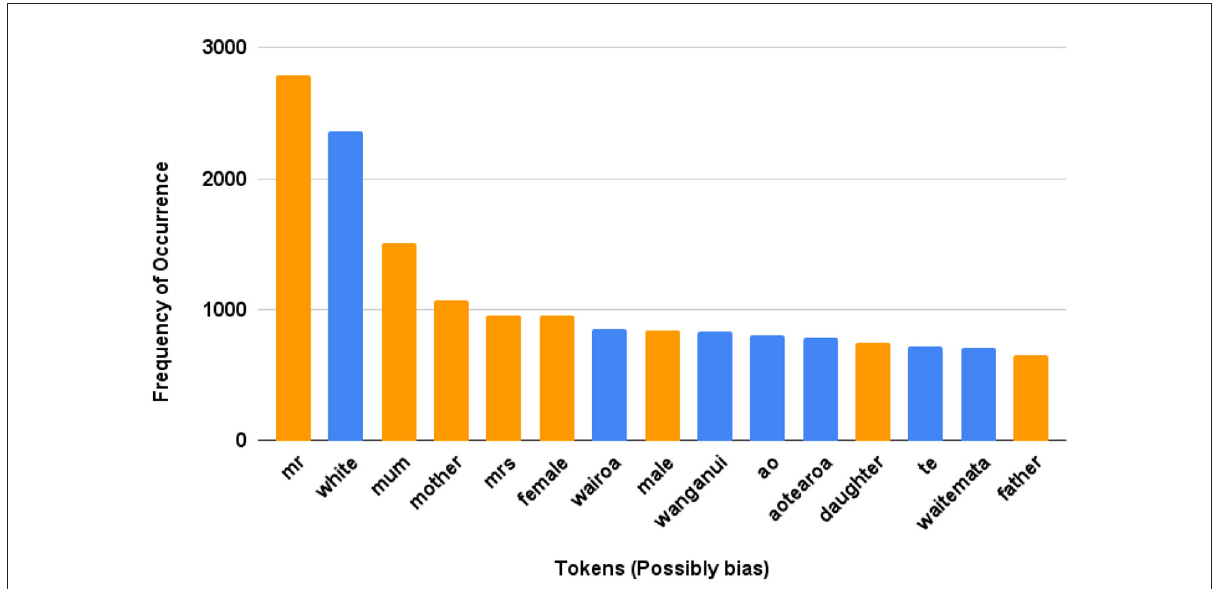
FIGURE4 NZ-GP Harms Data (Task 1). Examples of possible tokens among the most frequent tokens where possible bias due to gender references and ethnicity tokens are presented. M¯aori tokens: “wairoa” means long water, “Wairoa” is also a district name; “Wanganui” is a district, city and